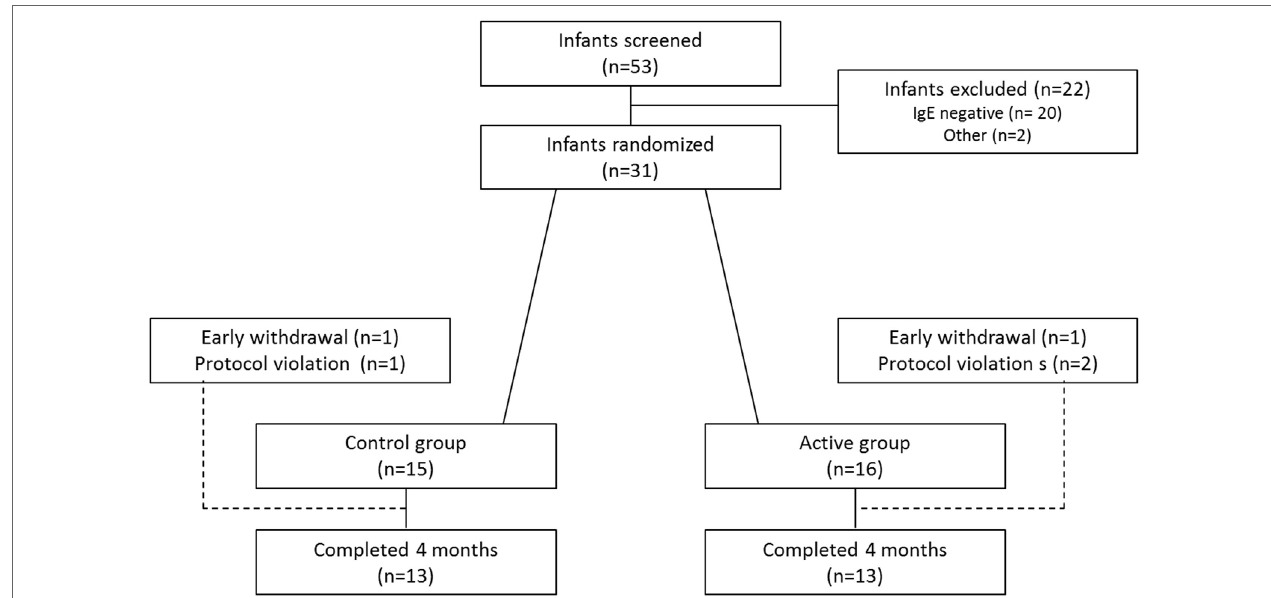
FigUre 1 | Flowchart of study inclusion and